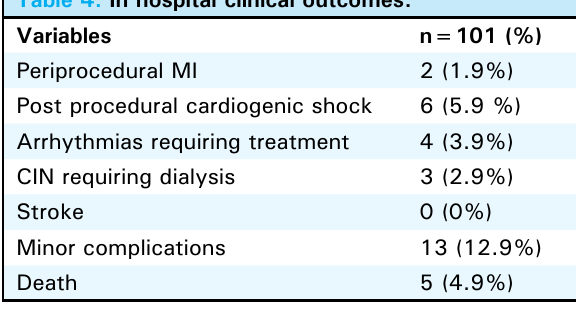
Table 4. In hospital clinical